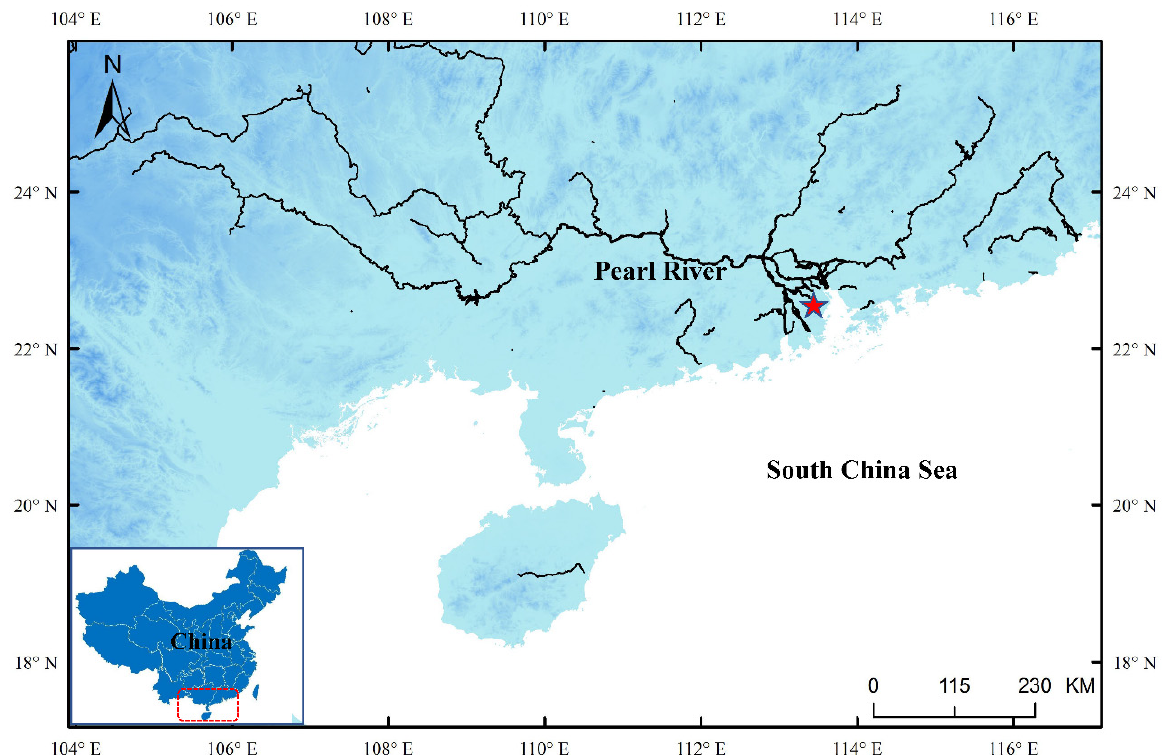
Figure 1. Sampling site of Anguilla japonica (red star). This map was generated using ArcGis software. Table 1. Genetic diversity indices of nine temporal samples based on mitochondrial DNA.